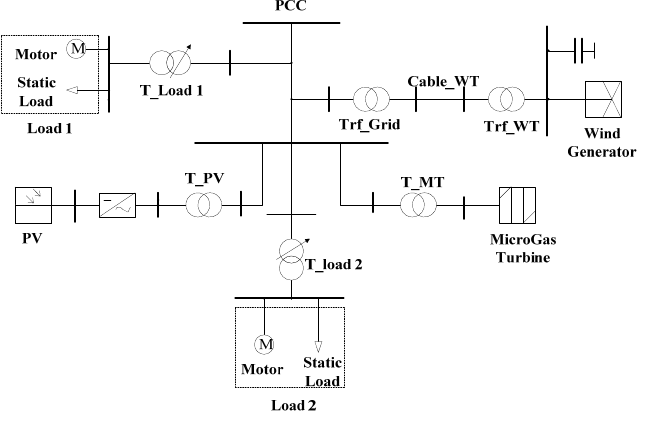
Figure 4. Microgrid system.